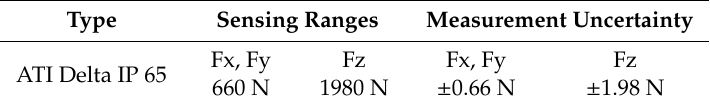
Table 3. Force sensor